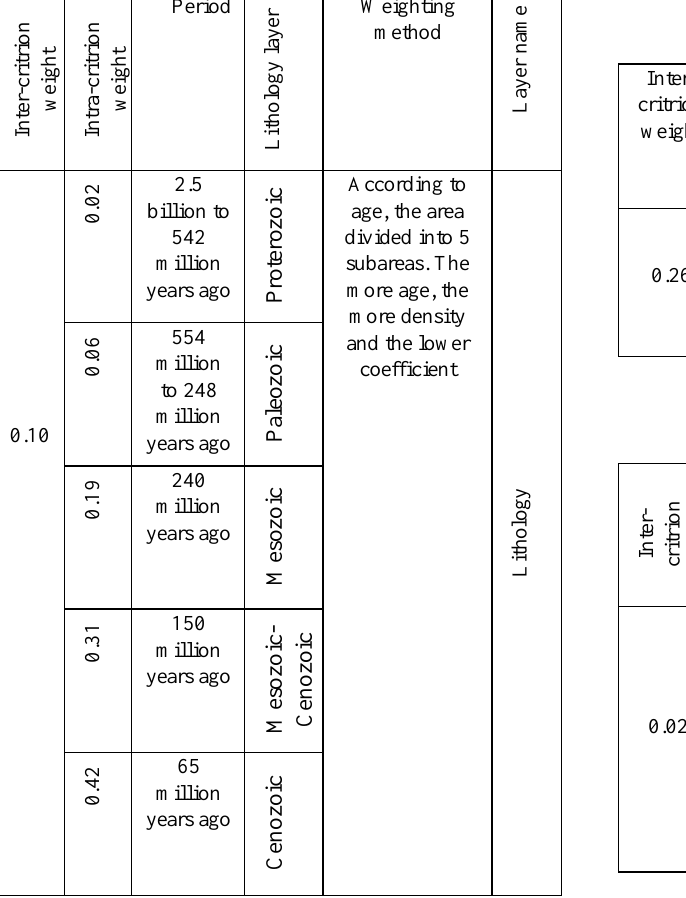
Table 4. Weighting land cover